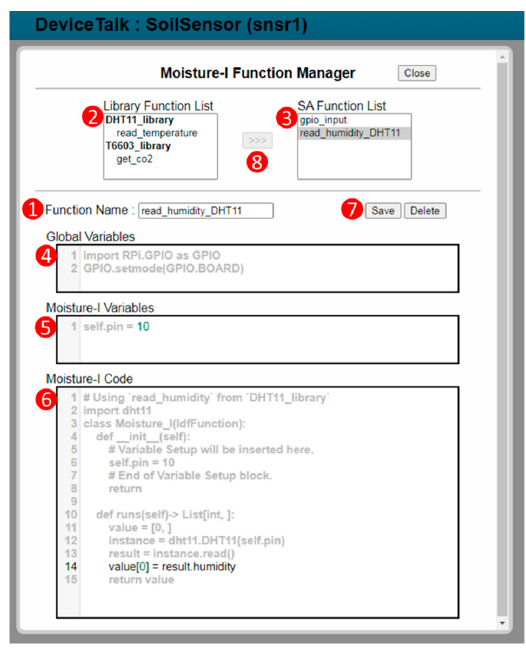
Figure 7. DF Function Manager.